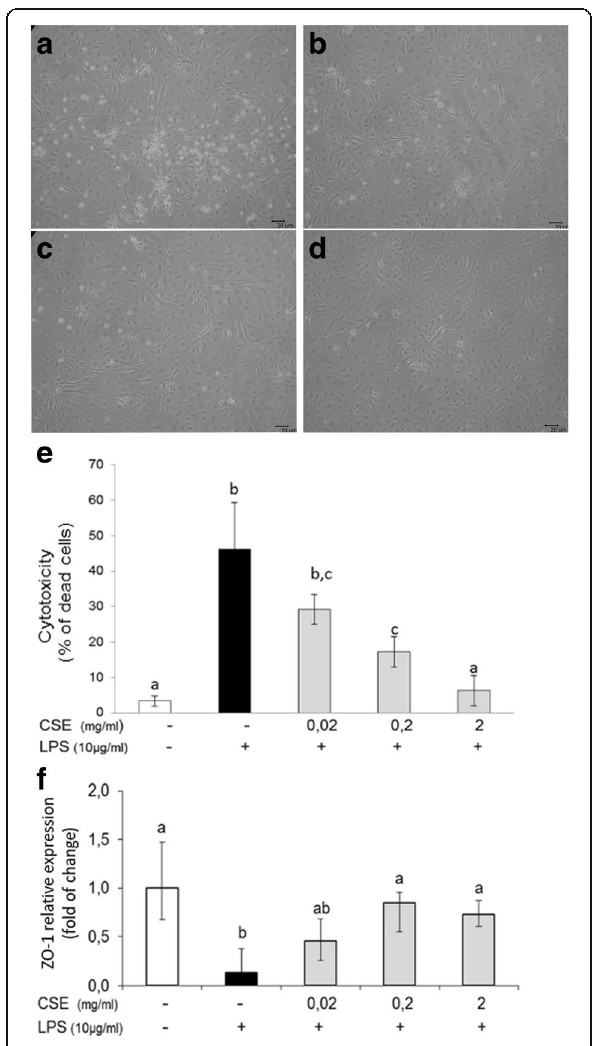
Fig. 1 Effect of Cucumis sativus L. extract (CSE) on LPS-induced pAECs toxicity. a Representative images of pAECs morphology under LPS (10 μ g/ml) stimulation ( b, c, d) and in the presence of increasing dose of CSE (0.02; 0.2; 2 mg/ml). e Protective effect of CSE on LPS-induced cytotoxicity; data shown are representative of at least three independent experiments and represent the mean ± SEM. f CSE restored the LPS-induced decrease of ZO-1 mRNA expression; relative expression was calculated as fold of change in respect to the control cells and error bar represents the range of relative gene expression. Different letters above the bars indicate significant differences ( p < 0.05 ANOVA post hoc Tukey ’ s